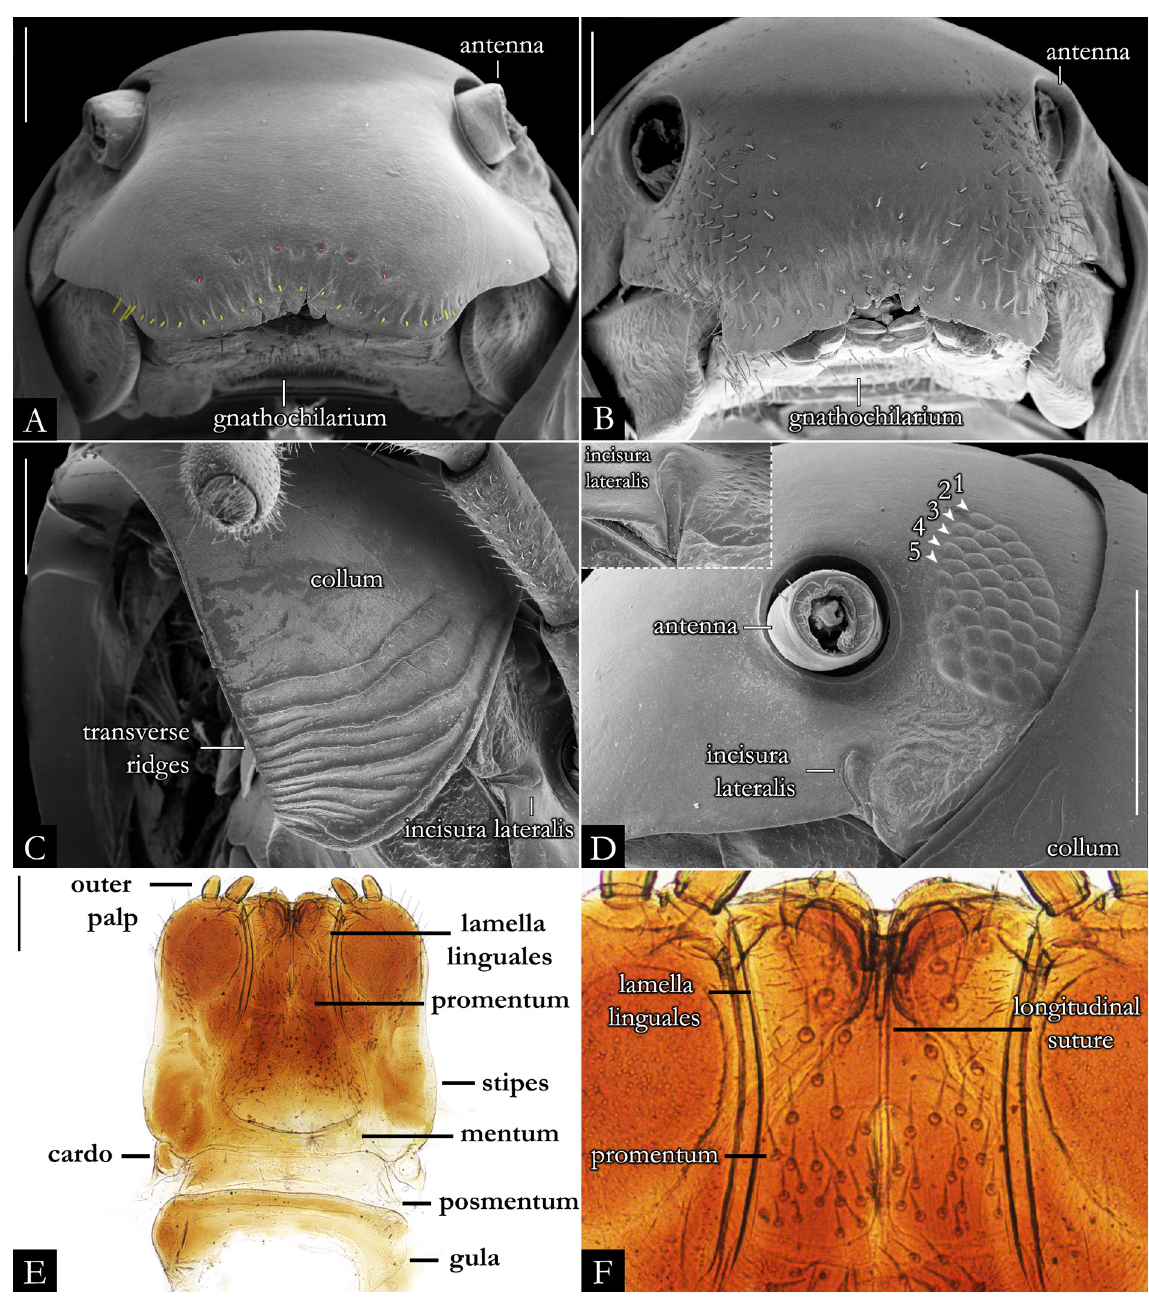
Fig. 19. SEM and microscope images. A . Head of Pseudonannolene robsoni Iniesta & Ferreira, 2014 (IBSP 3526), in frontal view. B . Head of P. occidentalis Schubart, 1958 (IBSP 1998), in frontal view. C . Collum of P. robsoni (IBSP 3506), in lateral view. D . Head of P. robsoni (IBSP 3526), in lateral view. E . Gnathochilarium of P. microzoporus Mauriès, 1987 (IBSP 3497). F . Detail of gnathochilarium of P. microzoporus (IBSP 3497). Scale bars: A–B = 500 µm; C, F, = 200 µm; D = 1 mm; E = 100